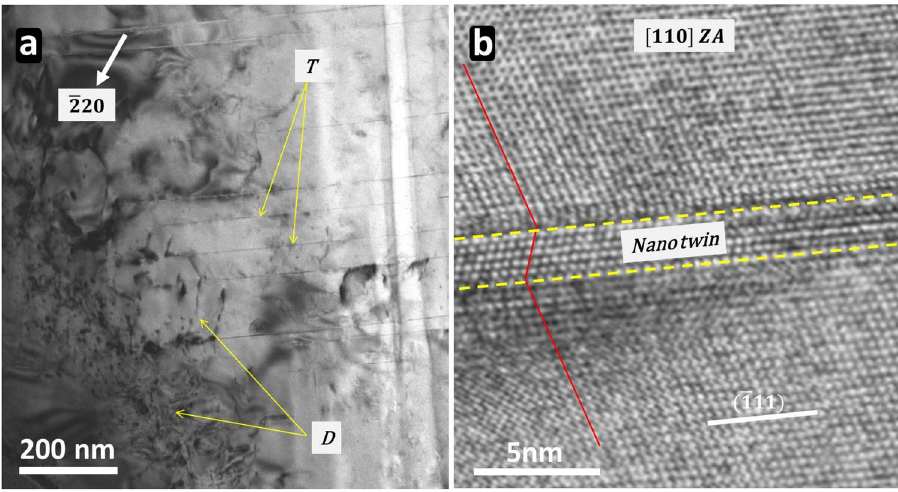
Figure 7. Bright field of a TEM transversal lamella of an InSb micro-pillar deformed at 20 °C in ( a ) and an HRTEM image revealing a nano-twin inside this lamella in ( b